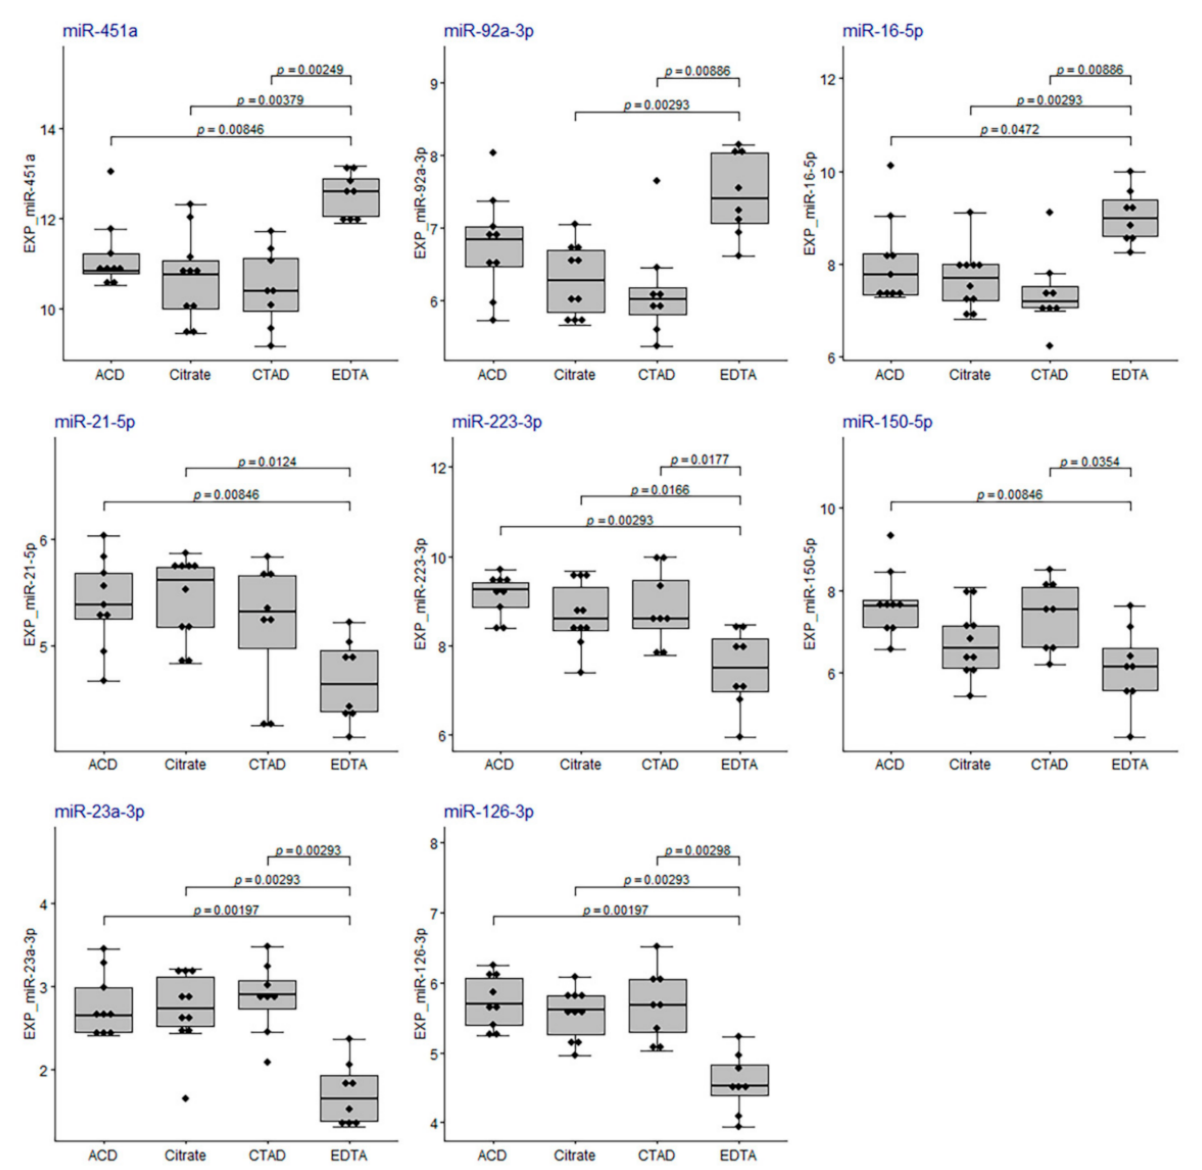
Figure 12. The distribution of the relative plasma levels of miRNAs normalized to miR-30e-5p. On the y -axis, relative plasma levels are marked as EXP_miR- . . . for each analyzed miRNA. The boxplots represent median and interquartile ranges (IQRs) in the box and values for individual samples in the dots. The Mann–Whitney U test p -values corrected by false discovery rate are given for the statistically significant pairwise